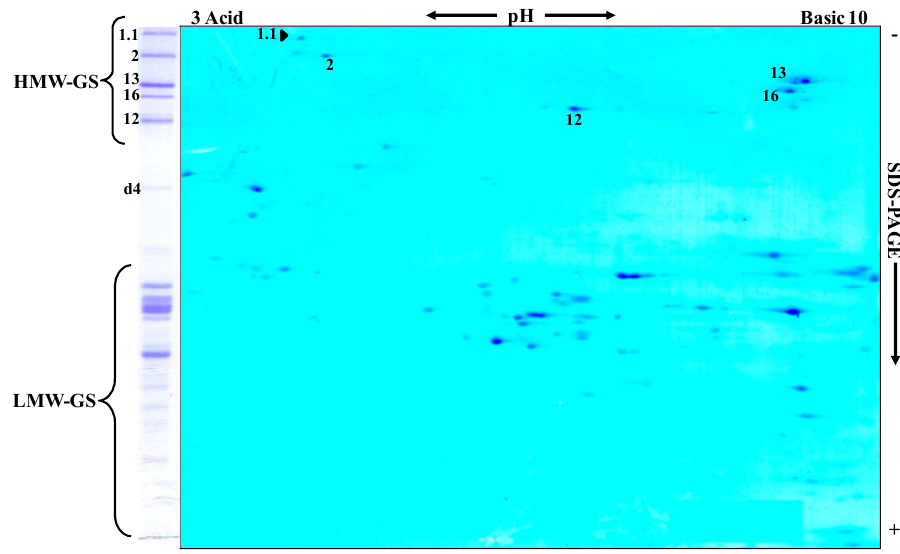
Figure 2. Two-dimensional electrophoresis pattern (IEF × SDS-PAGE) of the HMW-GS of wheat line ‘Barbela 28’. The arrowhead points to the Glu-A1 allele 1.1. One-dimensional SDS-PAGE separations are shown to the left of the two-dimensional